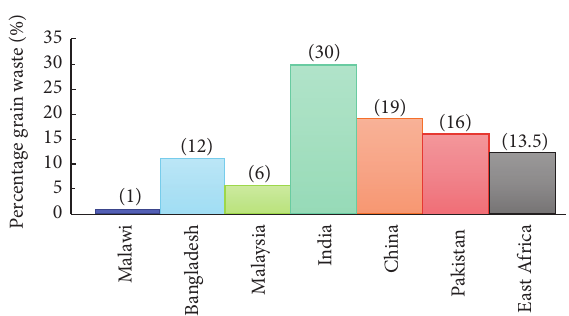
Figure 1: Percentage grain waste in selected developing and less developed countries.